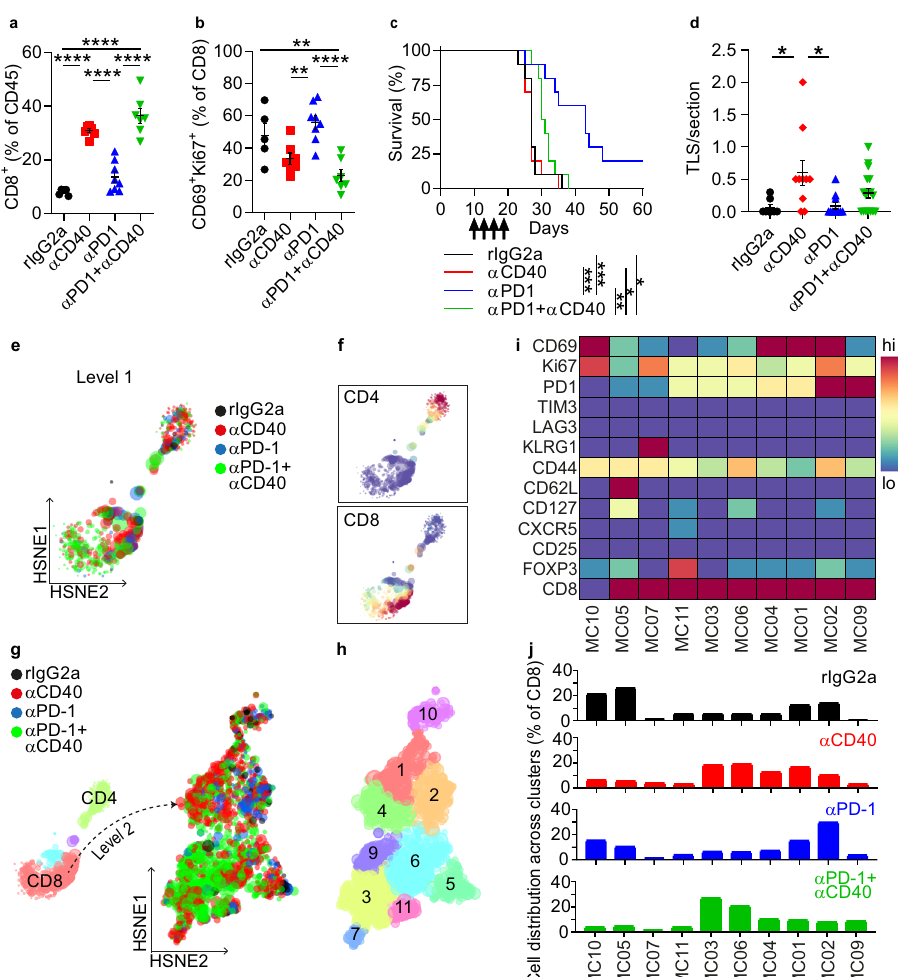
Fig. 5 α CD40-induced T cell hypofunction impaired the ef fi cacy of checkpoint blockade. All panels show data from GL261 tumor-bearing mice treated with rIgG2a, α CD40, and/or α PD1. a , b Quanti fi cation of a CD8 + T cells as a percentage of CD45 + cells and b CD69 + Ki67 + CD8 T cells in the brain in the indicated treatment groups. One-way ANOVA with Tukey ’ s correction for multiple comparisons. a All indicated p -values are p < 0.0001. b p (rIgG2a vs. α CD40 + α PD1) = 0.0073, p ( α CD40 vs. α PD1) = 0.0064, p ( α PD1 vs. α CD40 + α PD1) <0.0001. c Kaplan – Meier survival curves of mice treated as indicated on days 10, 13, 16, and 19 (as shown by arrows). n = 10 mice/group. p (rIgG2a vs. α PD1) = 0.0008, p (rIgG2a vs. α CD40 + α PD1) = 0.0211, p ( α CD40 vs. α PD1) = 0.0006, p ( α PD1 vs. α CD40 + B220 + clusters per section identi fi ed in the indicated treatment + α PD1) = 0.0025, p ( α CD40 vs. α CD40 + α PD1) = 0.037. Log-rank test. d Number of dense CD45 groups. n (rIgG2a) = 8 mice, n ( α CD40) = 10 mice, n ( α PD1) = 11 mice, n ( α PD1 + α CD40) = 17 mice. p (rIgG2a vs. α CD40) = 0.0139, p ( α CD40 vs. α PD1) = 0.0101. One-way ANOVA with Tukey ’ s correction for multiple comparisons. e Spatial clustering of tumor-in fi ltrating CD3 + cells in GL261 tumors in different treatment groups, determined by Level-1 Hierarchical Stochastic Neighbor Embedding (HSNE) analysis of fl ow cytometry data. f Expression of CD4 and CD8 across the HSNE plot shown in e . g Three meta-clusters (MC) of CD3 + T cells were identi fi ed by Level-1 HSNE analysis. Two MC were classi fi ed as mainly CD4 + or CD8 + . The latter was submitted to Level-2 HSNE analysis, revealing spatial clustering of tumor-in fi ltrating CD8 + cells in GL261 tumors in different treatment groups. h MCs of T cells identi fi ed in the HSNE plot in g . i Heat map showing the expression levels of proliferation, exhaustion, and memory markers on T cells in each MC. j Distribution of T cells from the indicated treatment group across each MC. a , b and e – j n (rIgG2a) = 5 mice, n ( α CD40)&( α PD1 + α CD40) = 7 mice, n ( α PD1) = 8 mice. For all graphs in this fi gure, * p < 0.05, ** p < 0.01, *** p < 0.001, **** p < 0.0001. Bars: mean ± SEM. Black circle indicates rat IgG2a (rIgG2a), red square or diamond indicate agonistic CD40 antibodies ( α CD40), blue triangle (pointing up) indicates PD1 blocking antibodies ( α PD1), green triangle (pointing down) indicates α PD1 + α CD40. Source data are provided as a Source Data fi elevated in α CD40-treated mice, with or without B cell depletion (Supplementary Fig. 10c). In conclusion, systemic delivery of α CD40 resulted in the expansion of CD11b-expressing B cells in the brain and spleen of glioma-bearing mice, which was associated with a systemic increase of IL-10. CD11b + B cells inhibited CD8 + T cell responses . Surface expression of CD11b on B cells inhibits CD4 + T cell responses,